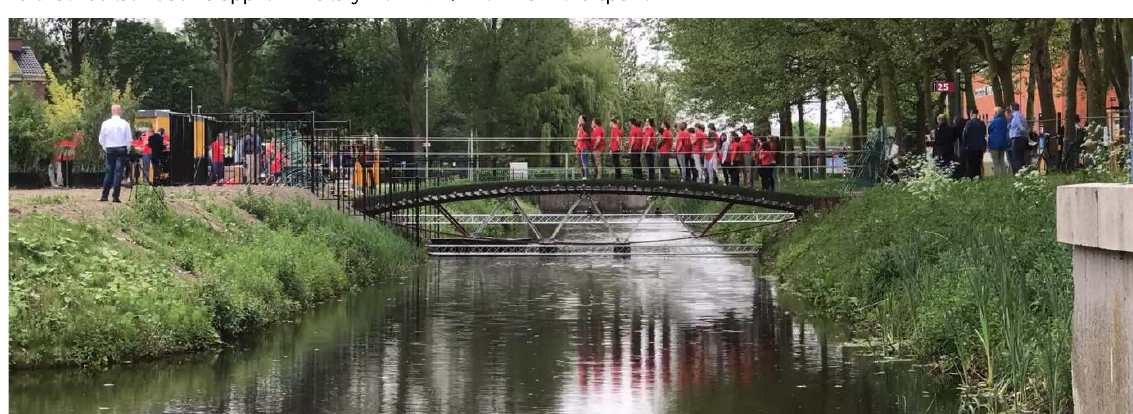
Fig. 28 Loadcase 2. Asymmetric load with 39 students; approx. 2.11